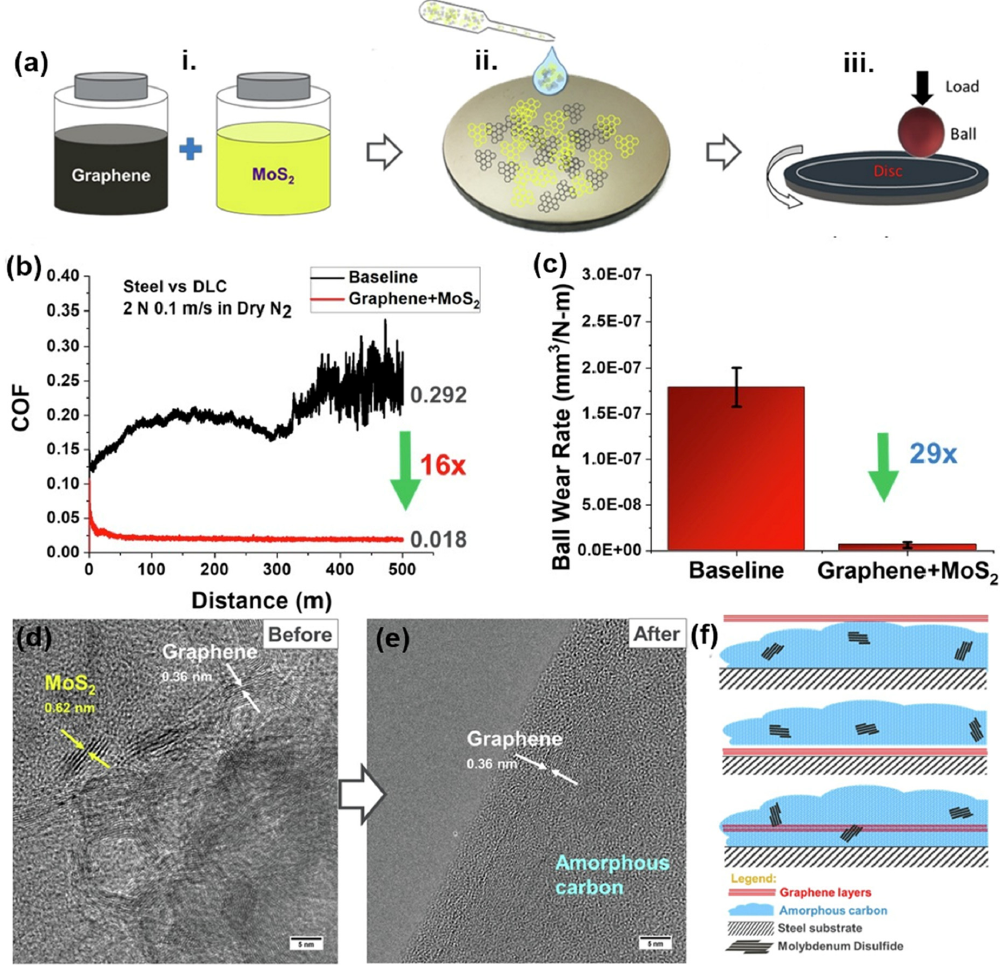
Figure 5. ( a ) Graphene + MoS 2 solid lubricant via drop-casting method: (i) Mixing of the solution-processed graphene and MoS 2 , (ii) Drop-casted onto steel disc and (iii) Ballon-disc configuration test. ( b ) COF graph for Baseline and Graphene + MoS 2 tests, ( c ) Comparison of ball wear rate for the Baseline and Grapehene + MoS 2 . TEM pictures indicating the ( d ) presence of Graphene and MoS 2 in